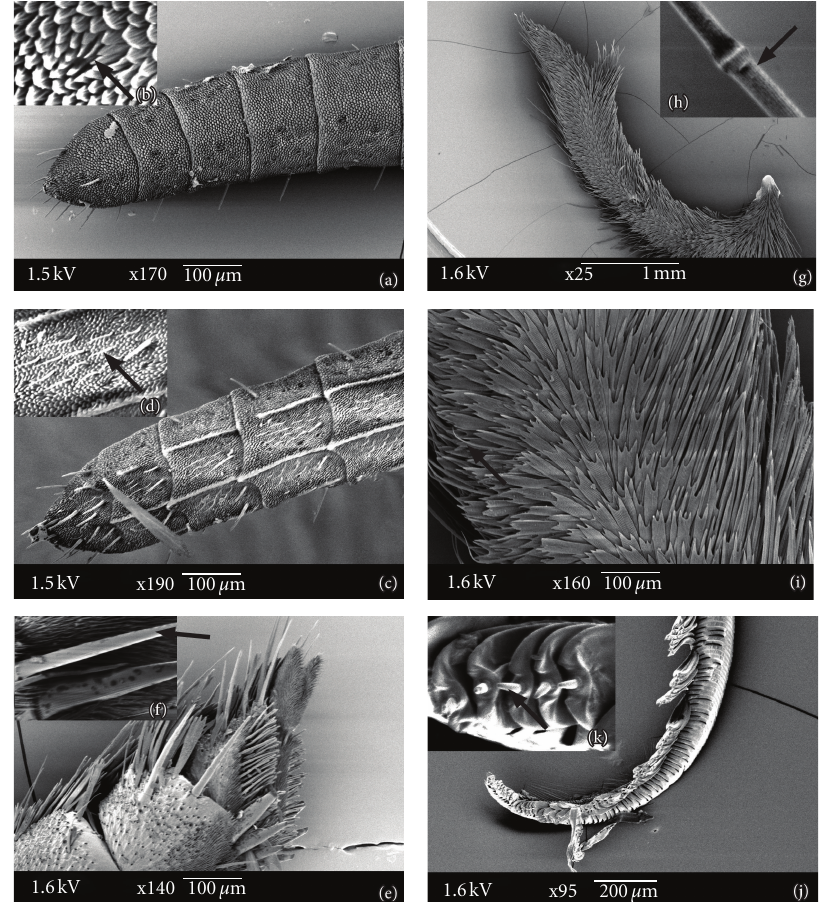
Figure 6: Scanning Electron Micrographs (SEMs) of Morpho helenor organs used for EAD analyses. (a-b) Antenna, dorsal surface. (c-d) Antenna, ventral surface. (e-f) Foreleg tip. (g–i) Labial palpus. (j-k) Galeae of proboscis. Closeup inserts show sensory organs potentially responsible for the observed EAD